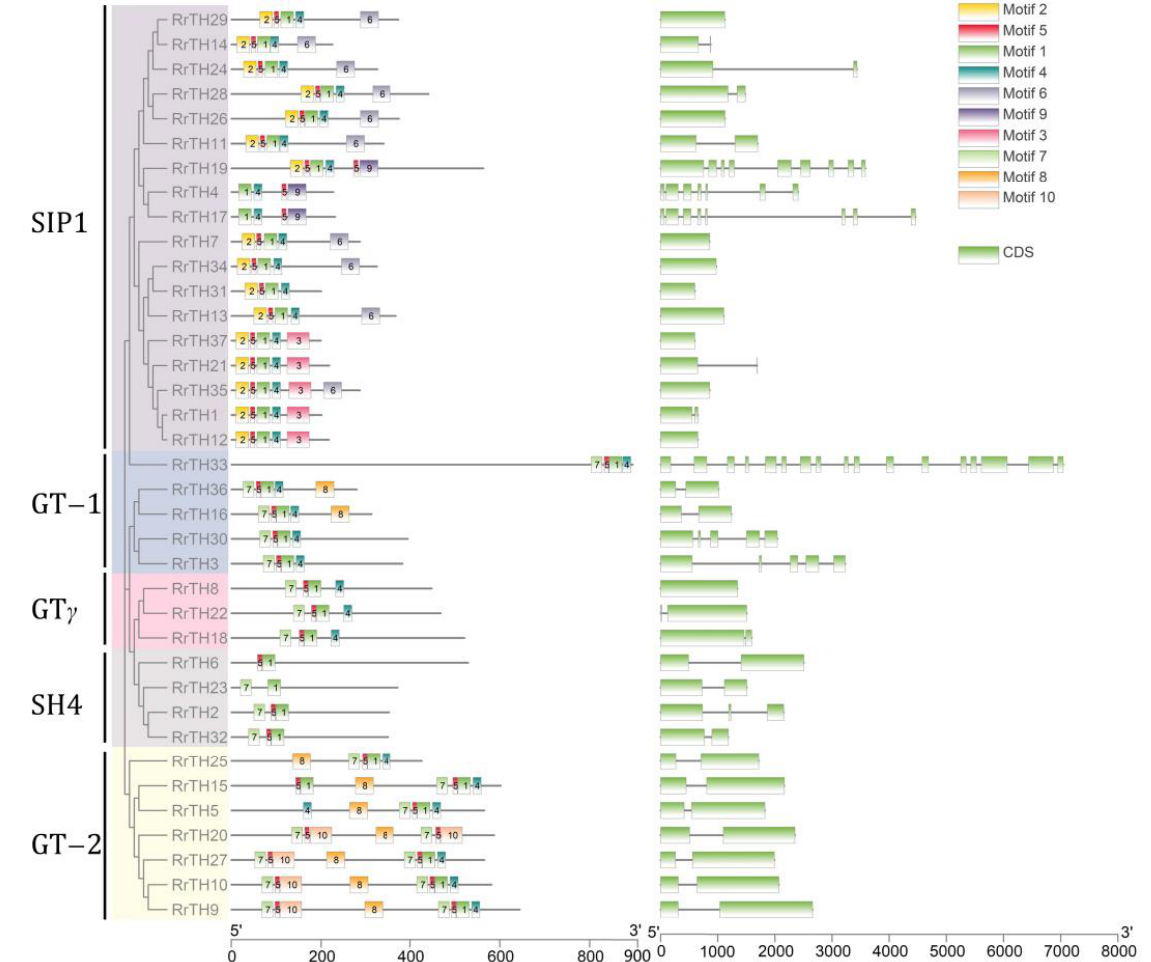
Figure 3. The conserved motifs and exon–intron structures of RrGT family. Five lineages are indicated by colored branches of NJ-dendrogram. The top 10 conserved motifs (boxes with numbers) were located by amino acid scale plate. The exons (green boxes) and introns (lines) were located by the nucleotide scale plate.